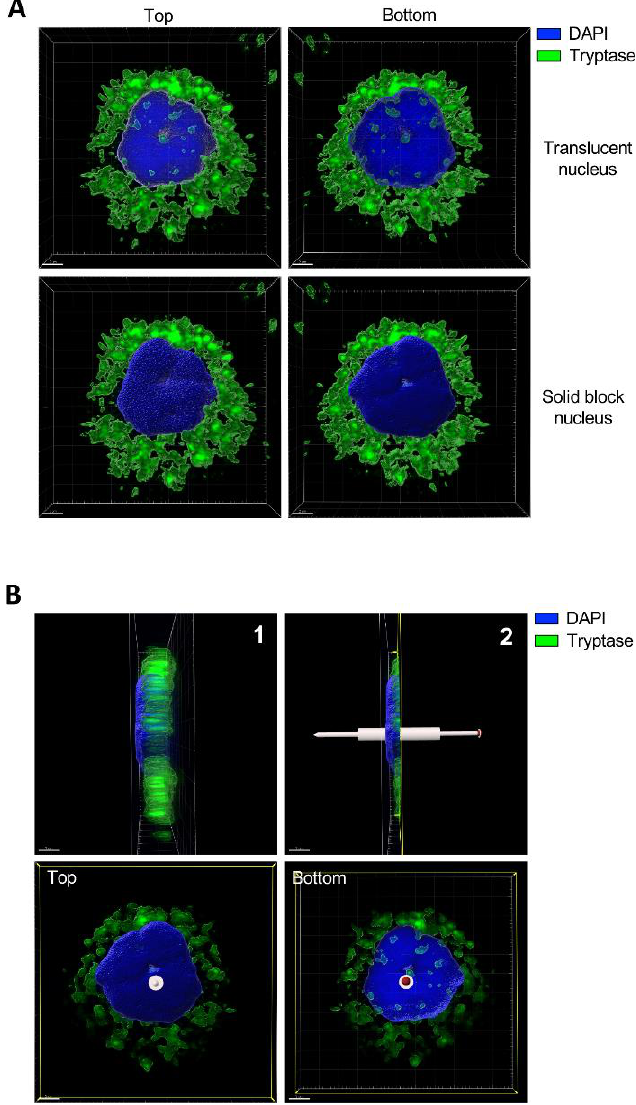
Figure 6. Tryptase is found in the nuclei of primary human skin mast cells. Human skin mast cells were stained for tryptase and with a nuclear dye (Hoechst33342), followed by confocal microscopy analysis. ( A ) 3-D view generated from Z-stack sections of a representative mast cell. Upper panels are showing top and bottom views from the same cell with a translucent nuclear structure. Note the presence of tryptase staining within the nucleus and that the staining is concealed when switching to solid block (lower panels), revealing that the tryptase is present within the nuclear compartment. Abundant tryptase staining is seen in the cytoplasm, representing secretory granules. ( B ) 1: Right side view from A (lower right panel). 2: Cross-section cut dividing the nucleus in half. Lower panels are showing top and bottom views from panel B2. Note that tryptase is present in different layers of the nucleus. The staining was performed twice and panels are showing a representative cell from more than ten individual cells analyzed.